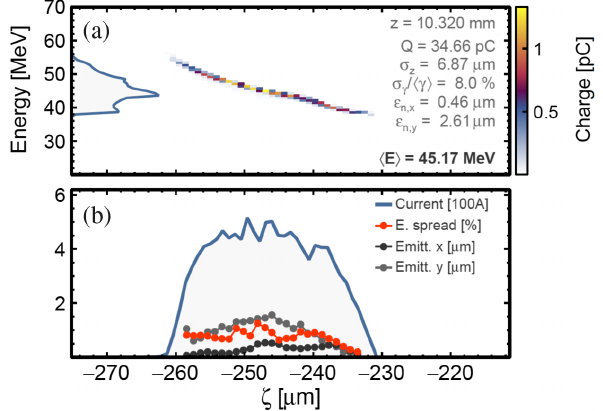
FIG. 9. Longitudinal phase space of the simulated witness- beam parameter (a) and slice parameters (b) after 10.32 mm of acceleration.